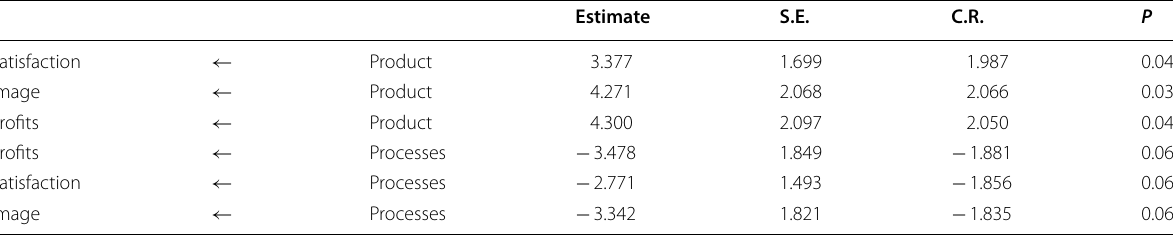
Table 6 Regression weights: (group number 1—default model)